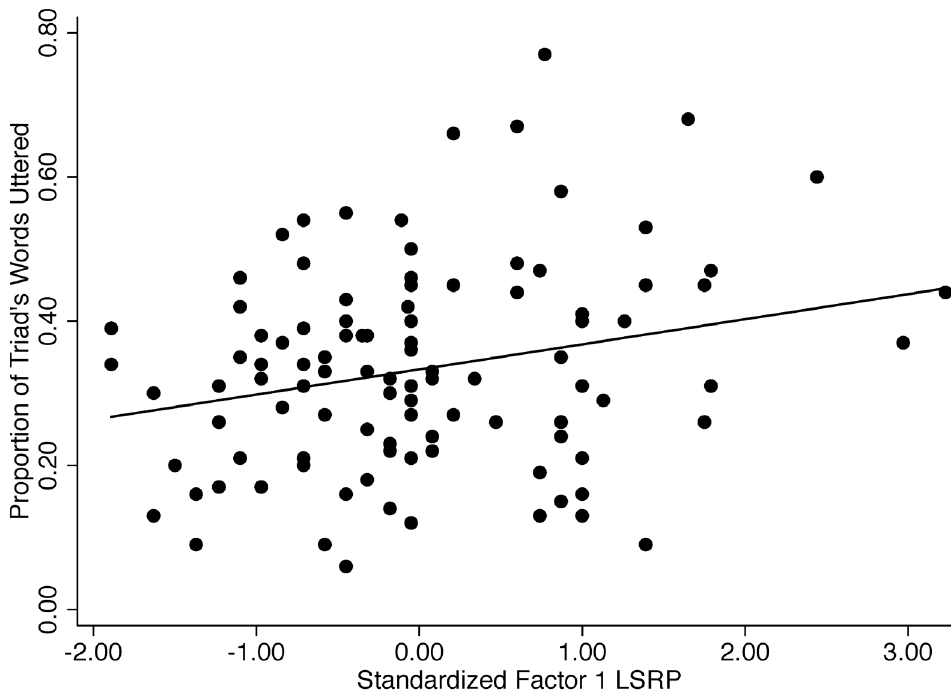
Figure 1. Regression of proportion of words uttered on F1 LSRP (psychopathy) score. N =105.